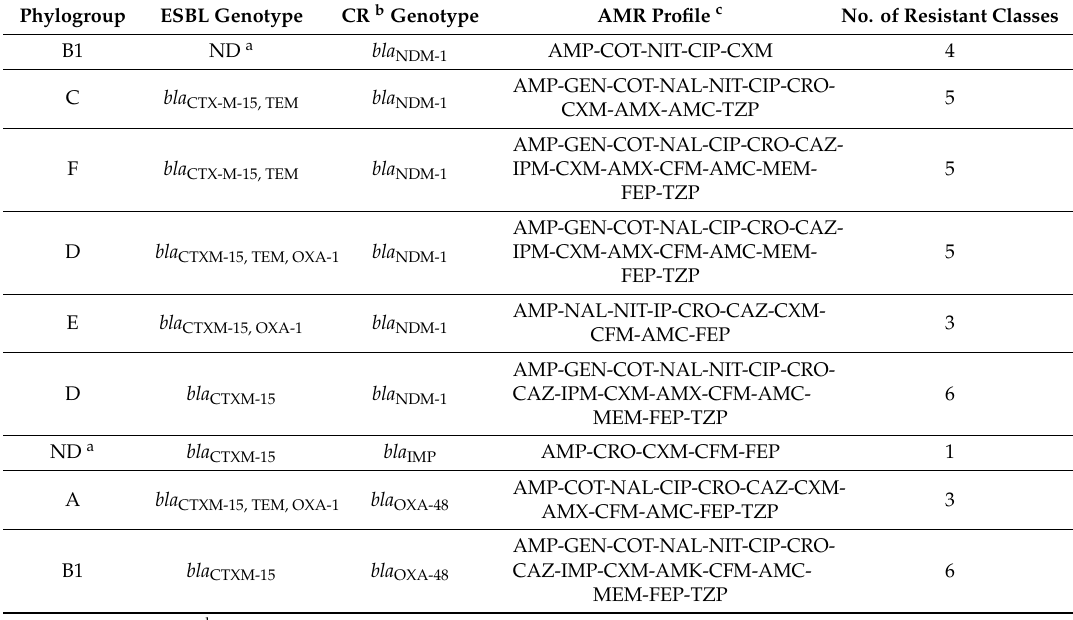
Table 3. Antibiotic resistance profiles of E. coli isolates harboring carbapenem resistance